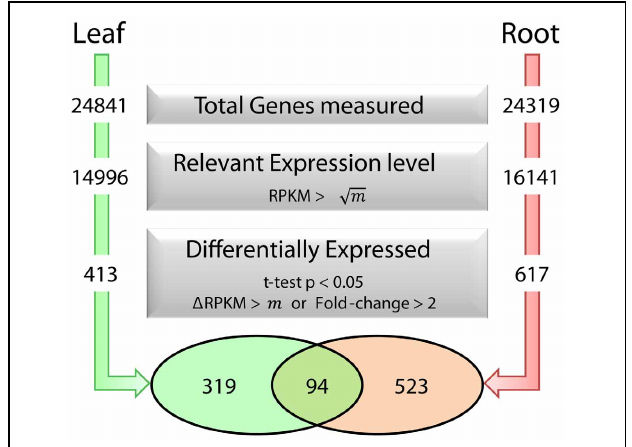
FIGURE 1 | Fe deficiency-induced transcriptional changes in leaves and roots and selection parameters used to identify differentially expressed genes. m represents the average RPKM value for all genes detected in each